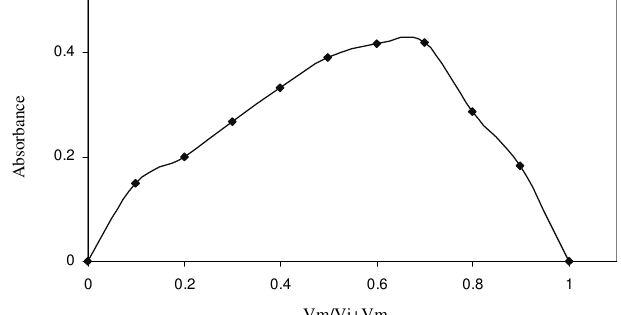
Figure 11. Determination of the stoichiometry of the reaction of: Gabapentin(5 x 10 -3 M) and cupric chloride (5 x 10 -3 M)